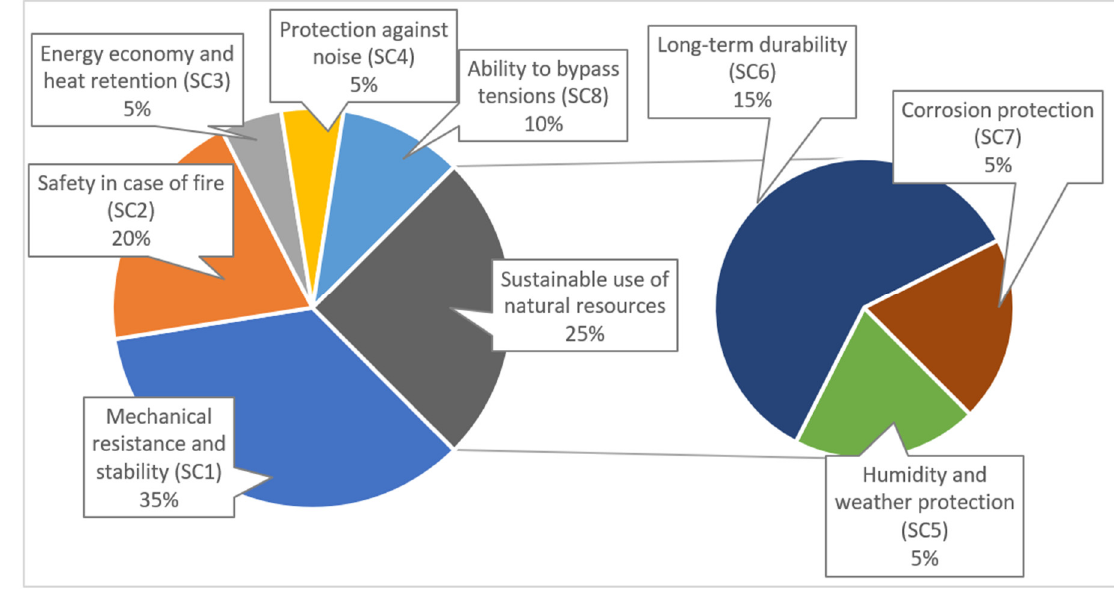
Figure 4. The weight distribution of the severity categories [7].